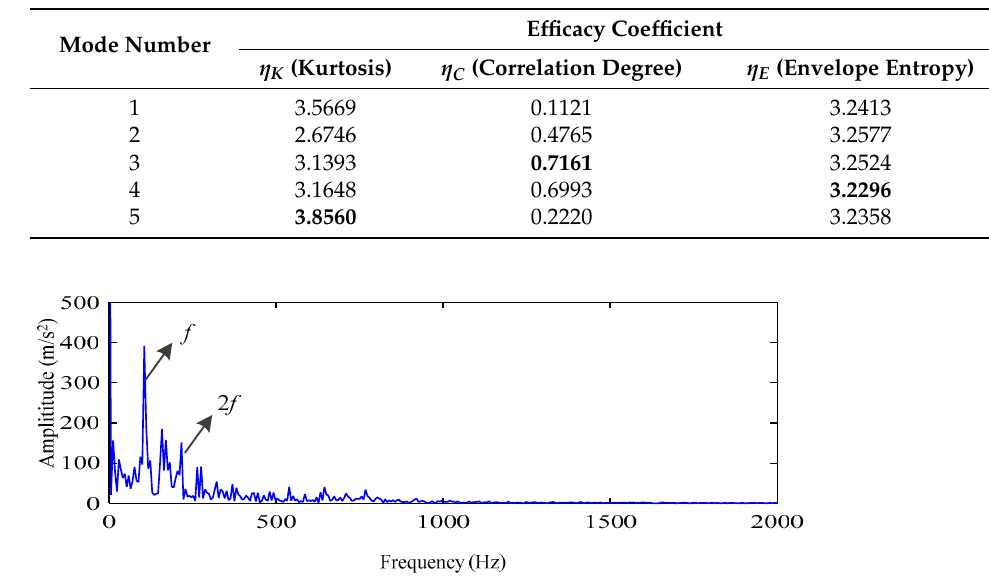
Table 2. Efficacy coefficients corresponding to Decomposed Mode components for outer ring defect.